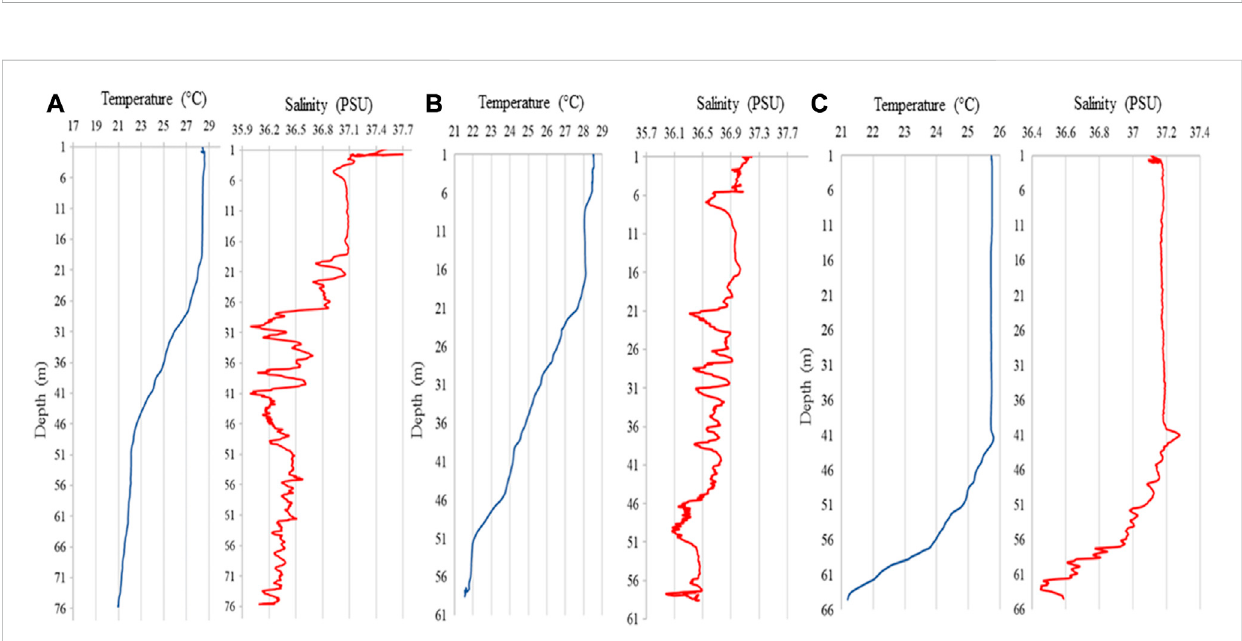
Frontiers in Remote